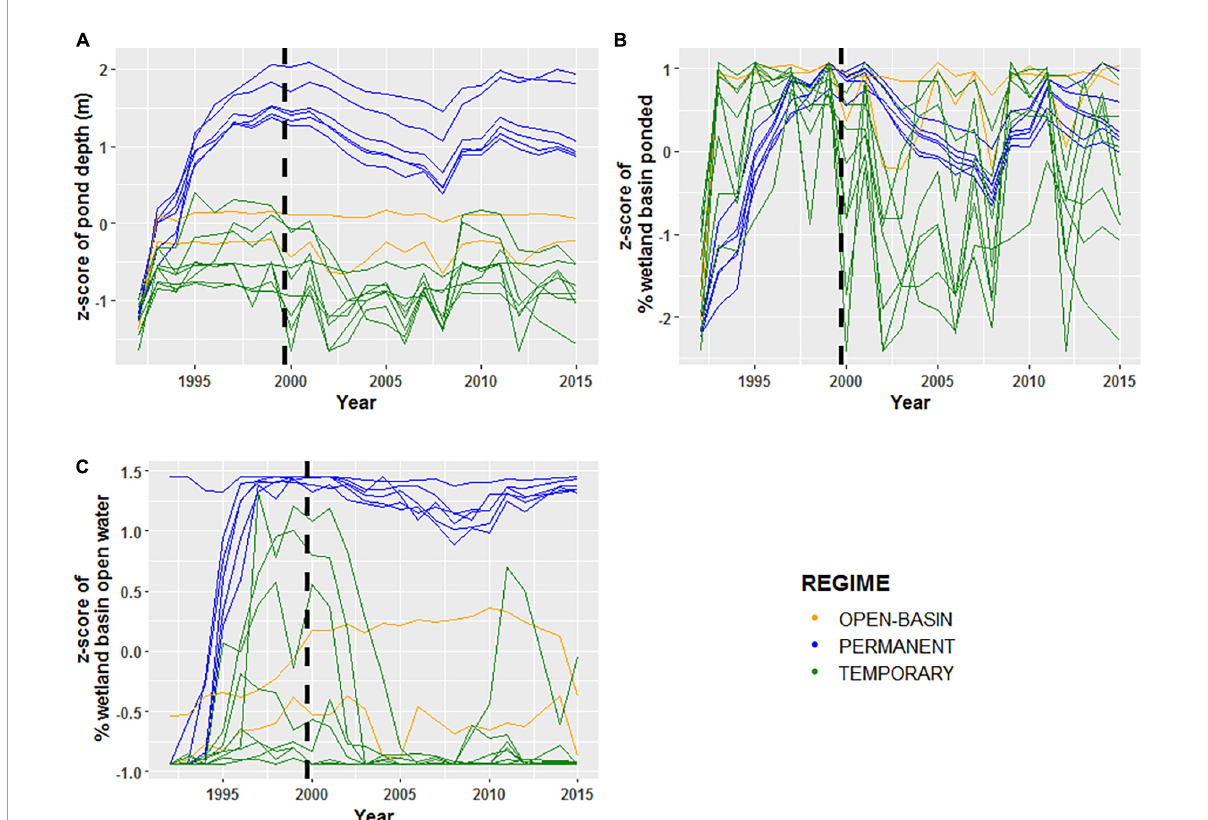
FIGURE2 Normalized z-scores of panels (A) maximum observed annual ponded-water depths (m), (B) maximum ponded-water extent (%), and (C) open-water area (%) for 16 Cottonwood Lake study area wetlands sampled from 1992 to 2015. For each plot, green lines represent temporarily ponded wetlands (T wetlands), blue lines represent permanently ponded wetlands with closed basins (P wetlands), and orange lines represent permanently ponded wetlands with open basins (OB wetland). The black dashed lines indicate the transition for the “filling period” (1992–2000) and the “post-filling period” (2001–2015).